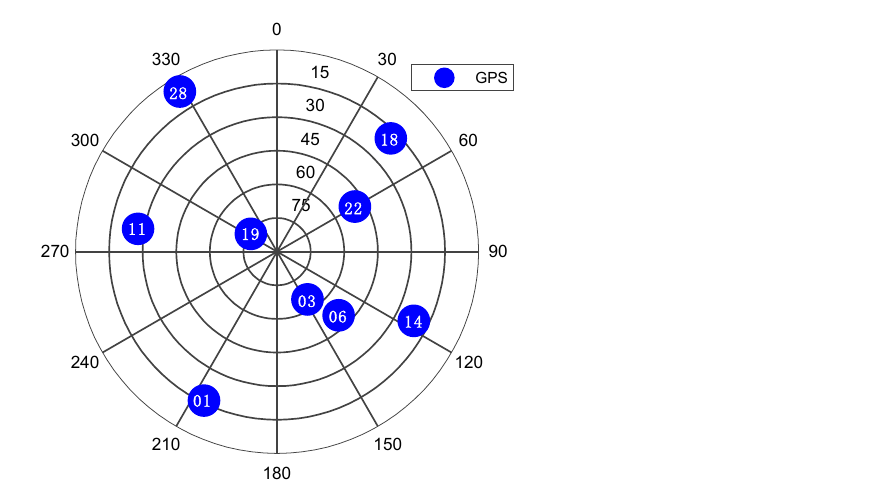
9 of 16 Figure 5. Model-fit MSE reduction Q m versus the number of candidate terms of modeling the measured correlation function of GPS satellite PRN 10. To verify the proposed method’s performance, real GPS L1 data were generated us- ing the Spirent GSS6700 simulator and logged using NovAtel FireHose front-end. The tests were performed in static mode. The starting point was chosen at a point in Kingston, Ontario, at latitude 44°13.726 ′ , longitude − 76°27.948 ′ and height 100 m. There are nine GPS satellites available above a 5-degree elevation mask at the initial location, as shown in Figure 6. The real RF data were down-converted to the baseband and sampled at a fre- quency of 10 MHz and quantified with 4 bits. The raw GPS samples were processed using